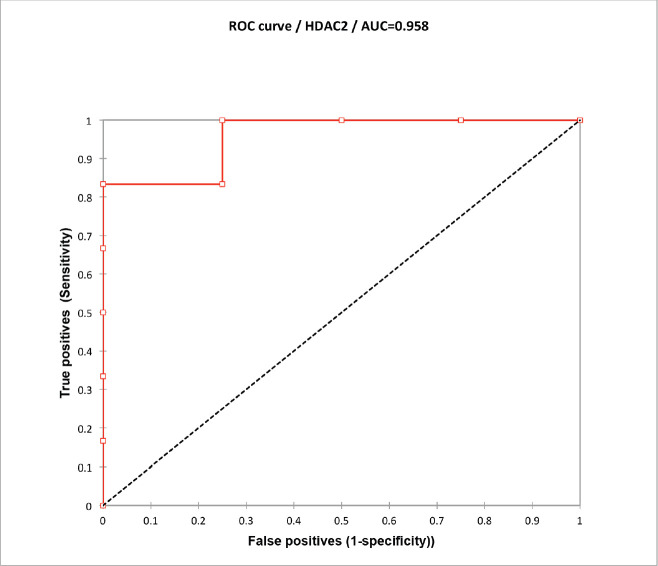
ROC curve analysis of HDAC2 H-score. Values over 170 correlated with DFS at 6 months with a sensitivity of 83% and specificity of 100%.